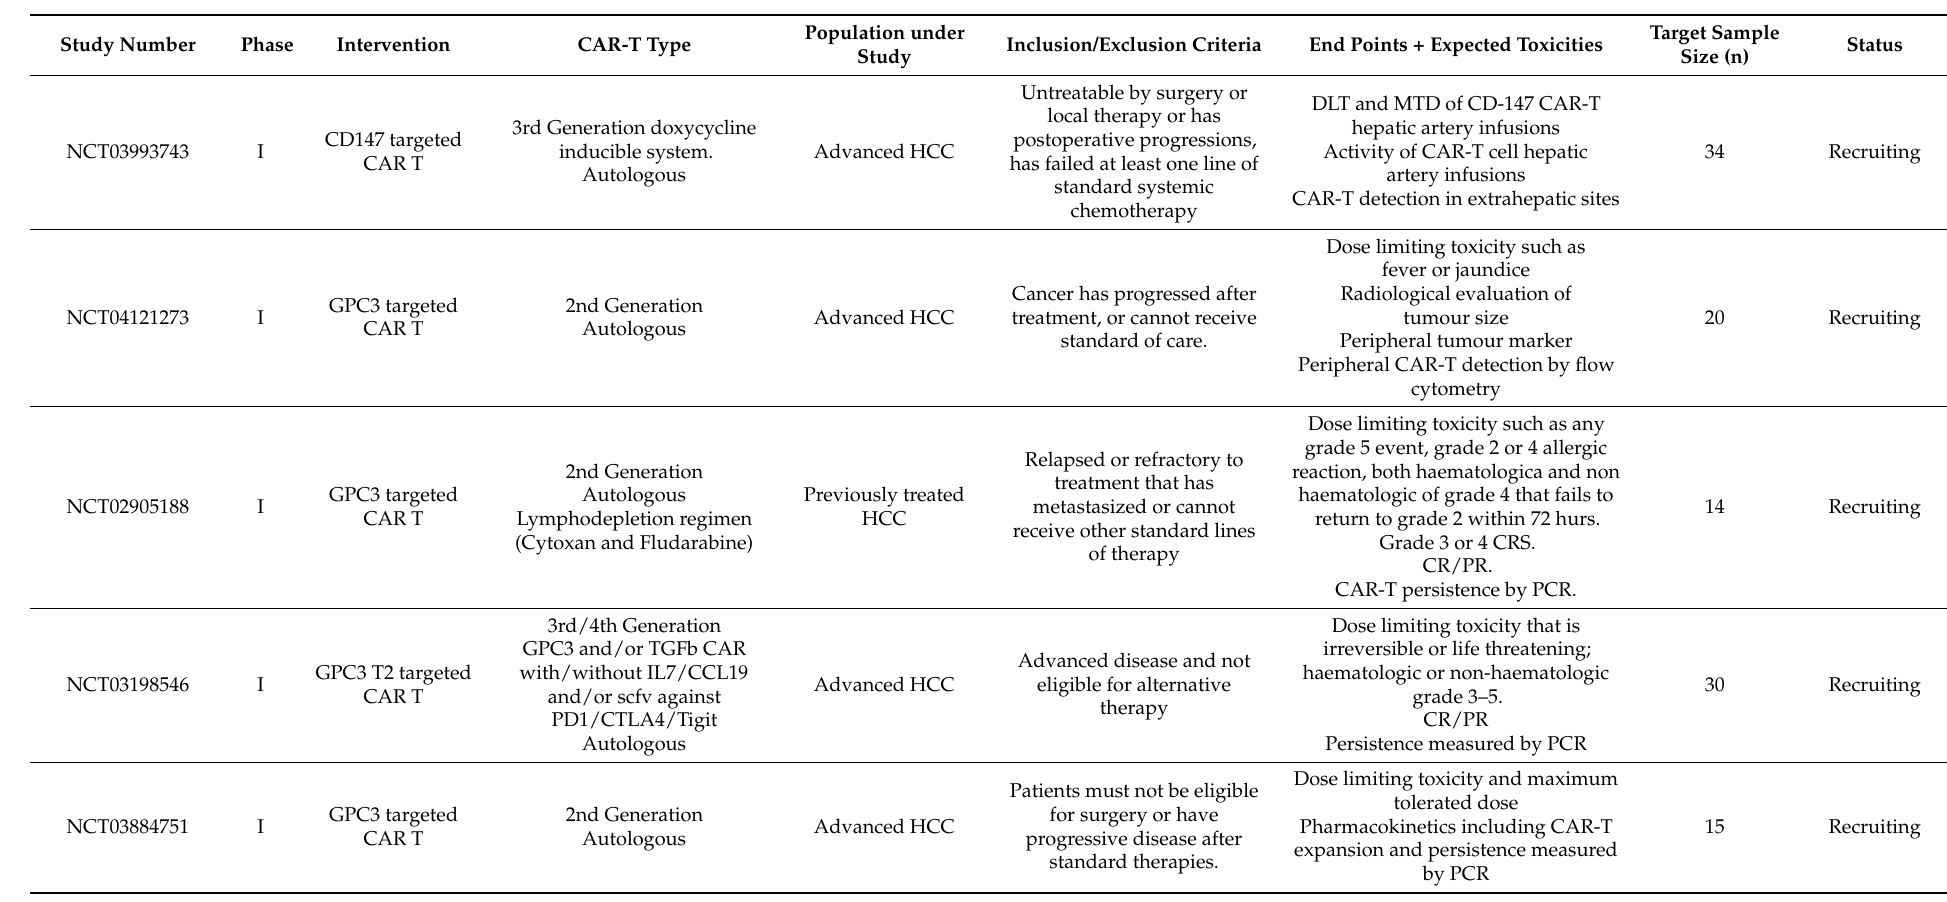
Table 1. CAR for HCC—only included trials with known status, all trials are for adult cancers. Information included where available, however due to non-uniform reporting of clinical trial details there is some